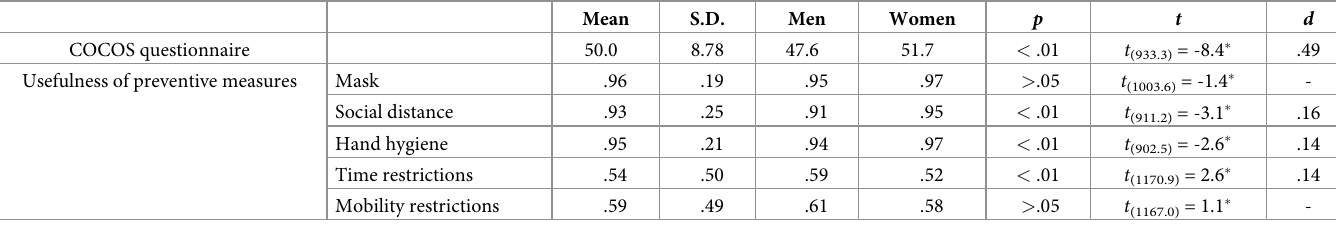
Table 3. Descriptive statistics and sex differences in the COCOS questionnaire and the items on the usefulness of preventive